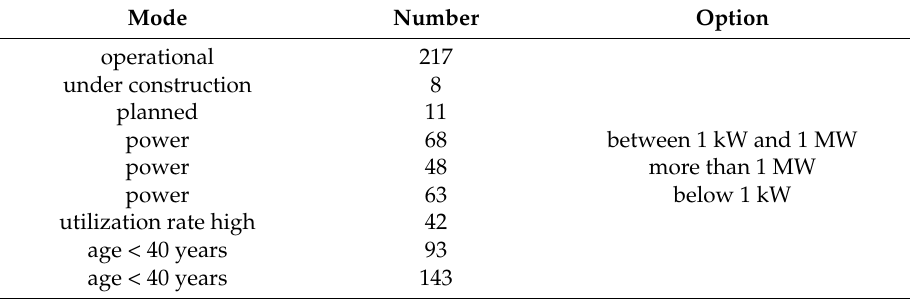
Table 3. Specification of research reactors according to their power, utilization and